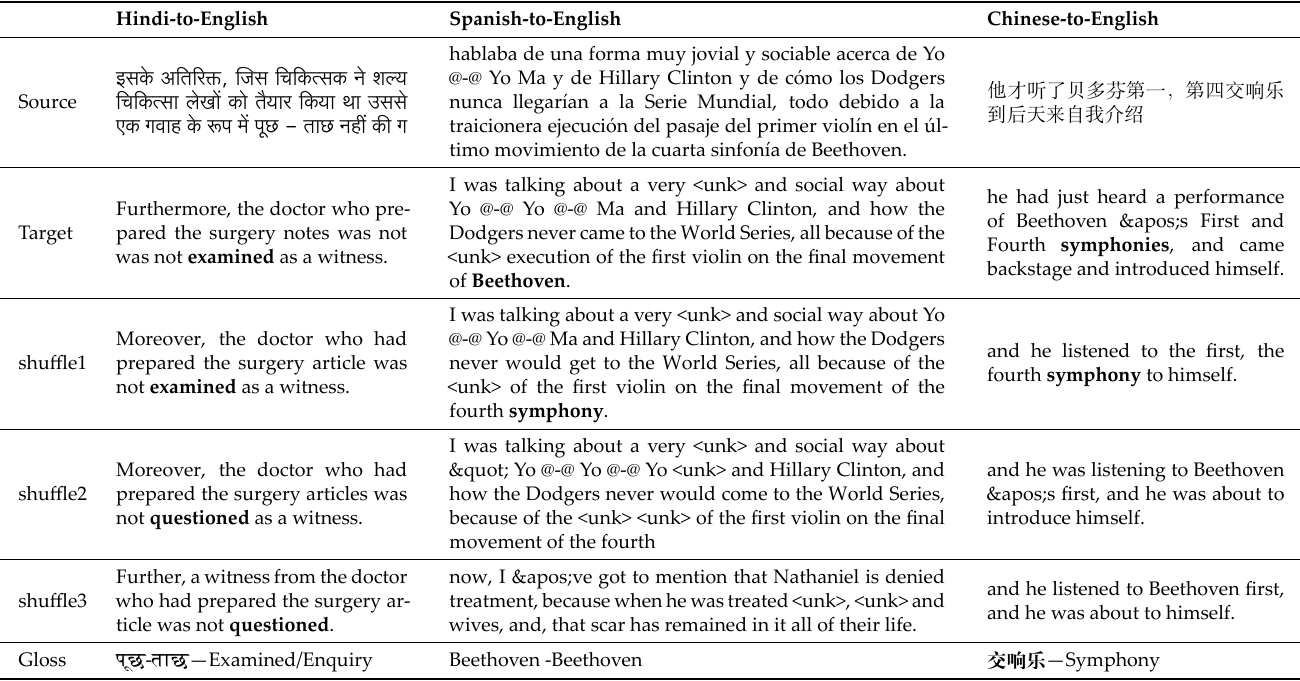
Table 8. Context‑sensitive sentence example for the three language pairs.